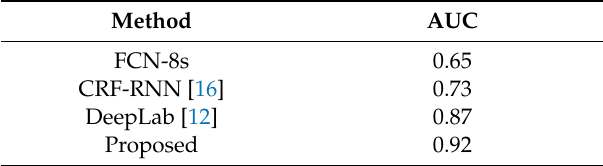
Table 2. Area under the curve (AUC) values of di ff erent